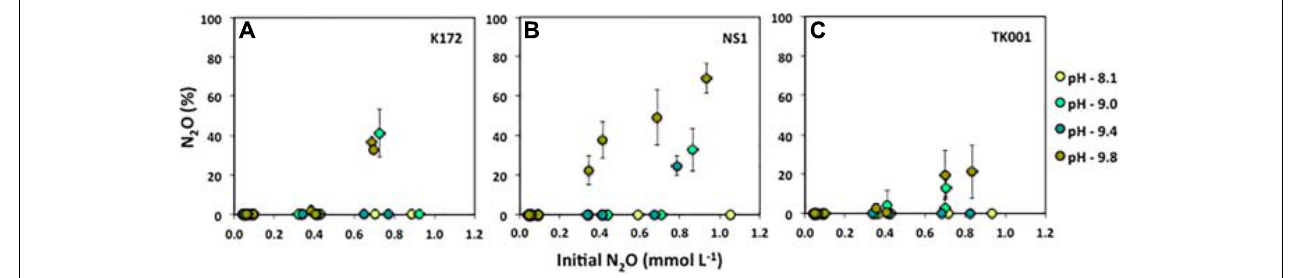
FIGURE 5 | Percent N 2 O REMAINING calculated as ([N 2 O]/[N 2 O + N 2 ])*100 after 15 days incubation of batch cultures of three different Thauera strains (K172, NS1 and TK001) as a function of varying initial N 2 O concentrations (0.05 to ∼ 1.0 mmol L − 1 ), and varying initial pH values (8.10 to 9.80). Error bars represent standard errors for two